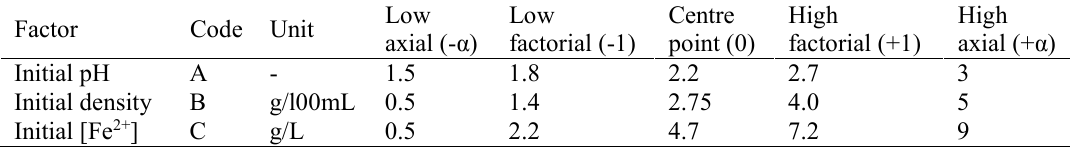
Low Low Centre High High axial (-α) factorial (-1) point (0) factorial (+1) axial (+α)